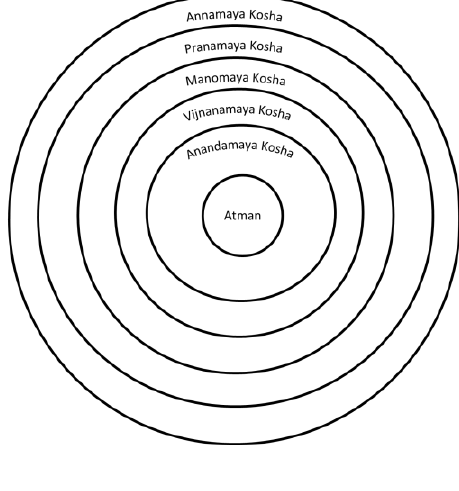
Figure 1: Pancha